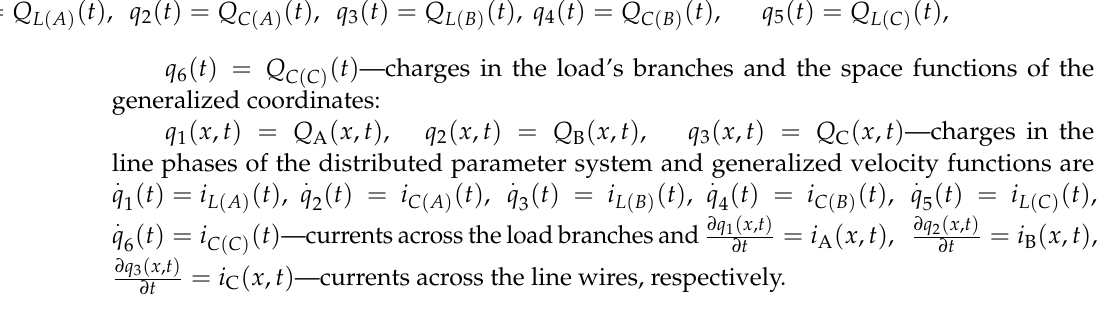
—currents across the line wires, respectively.